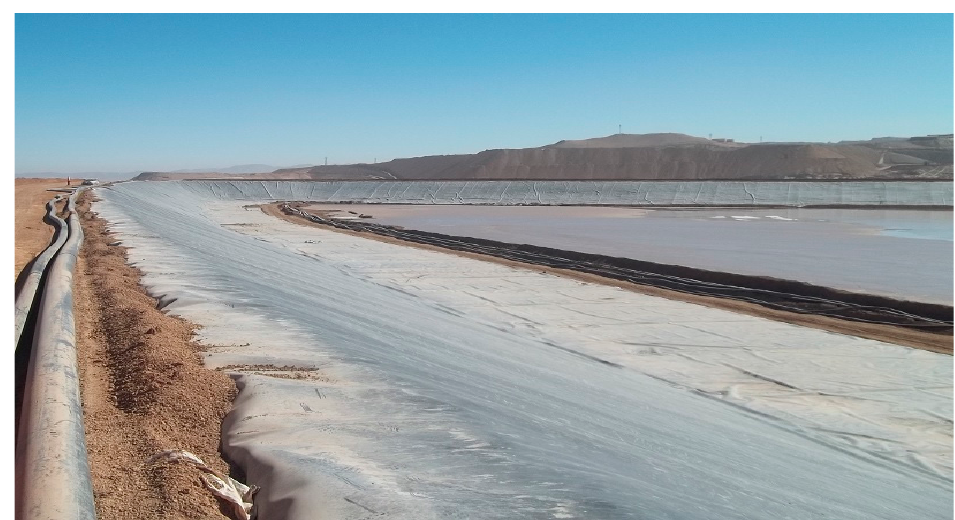
Figure 8. Mantos Blancos Disposal of Thickened Slimes in Tailings Storage Facility [39].